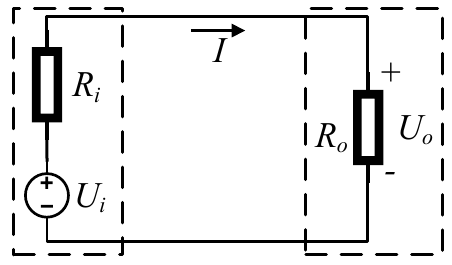
Figure 7. Photovoltaic cell linear equivalent circuit.